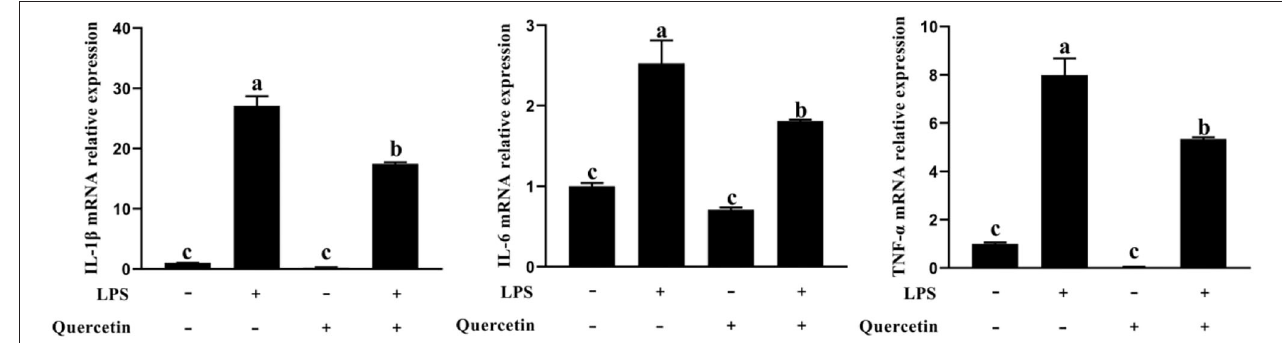
FIGURE 4 | Effects of quercetin on the mRNA expression of pro-inflammatory cytokines (IL-1 β , IL-6, and TNF- α ) in LPS-induced BMECs. BMECs were treated with 100 µ g/ml of quercetin in the presence of 1 µ g/ml of LPS for 6h. The mRNA expressions of IL-1 β , IL-6, and TNF- α in BMEC were assayed by qRT-PCR. Data presented are mean ± SEM ( n = 3). Different lowercase letters in the bar chart indicate significant differences ( P < 0.05).